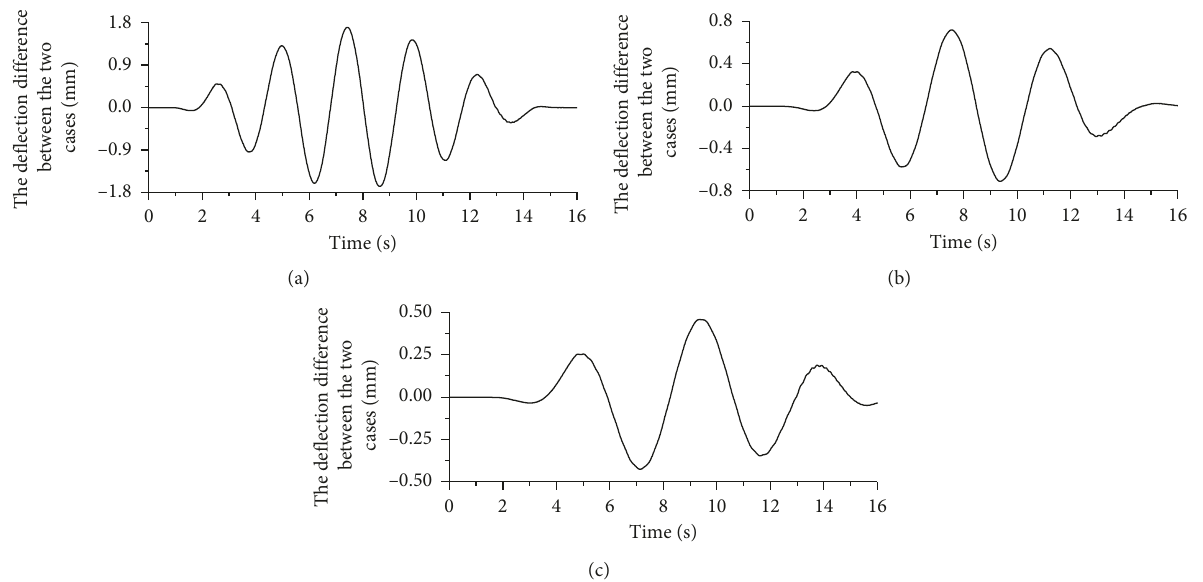
Figure 12: The difference between the two models: (a) when the cable length is 6m; (b) when the cable length is 14m; (c) when the cable length is